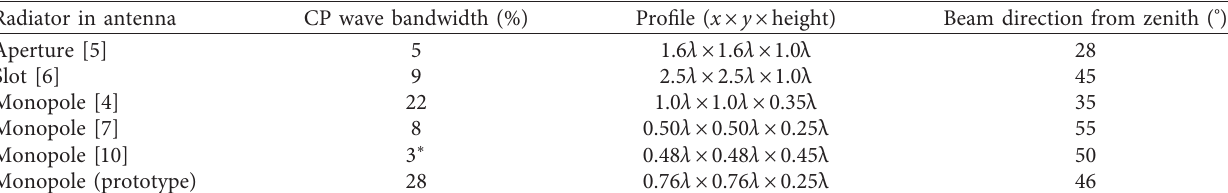
Table 1: Comparison with other nonplanar